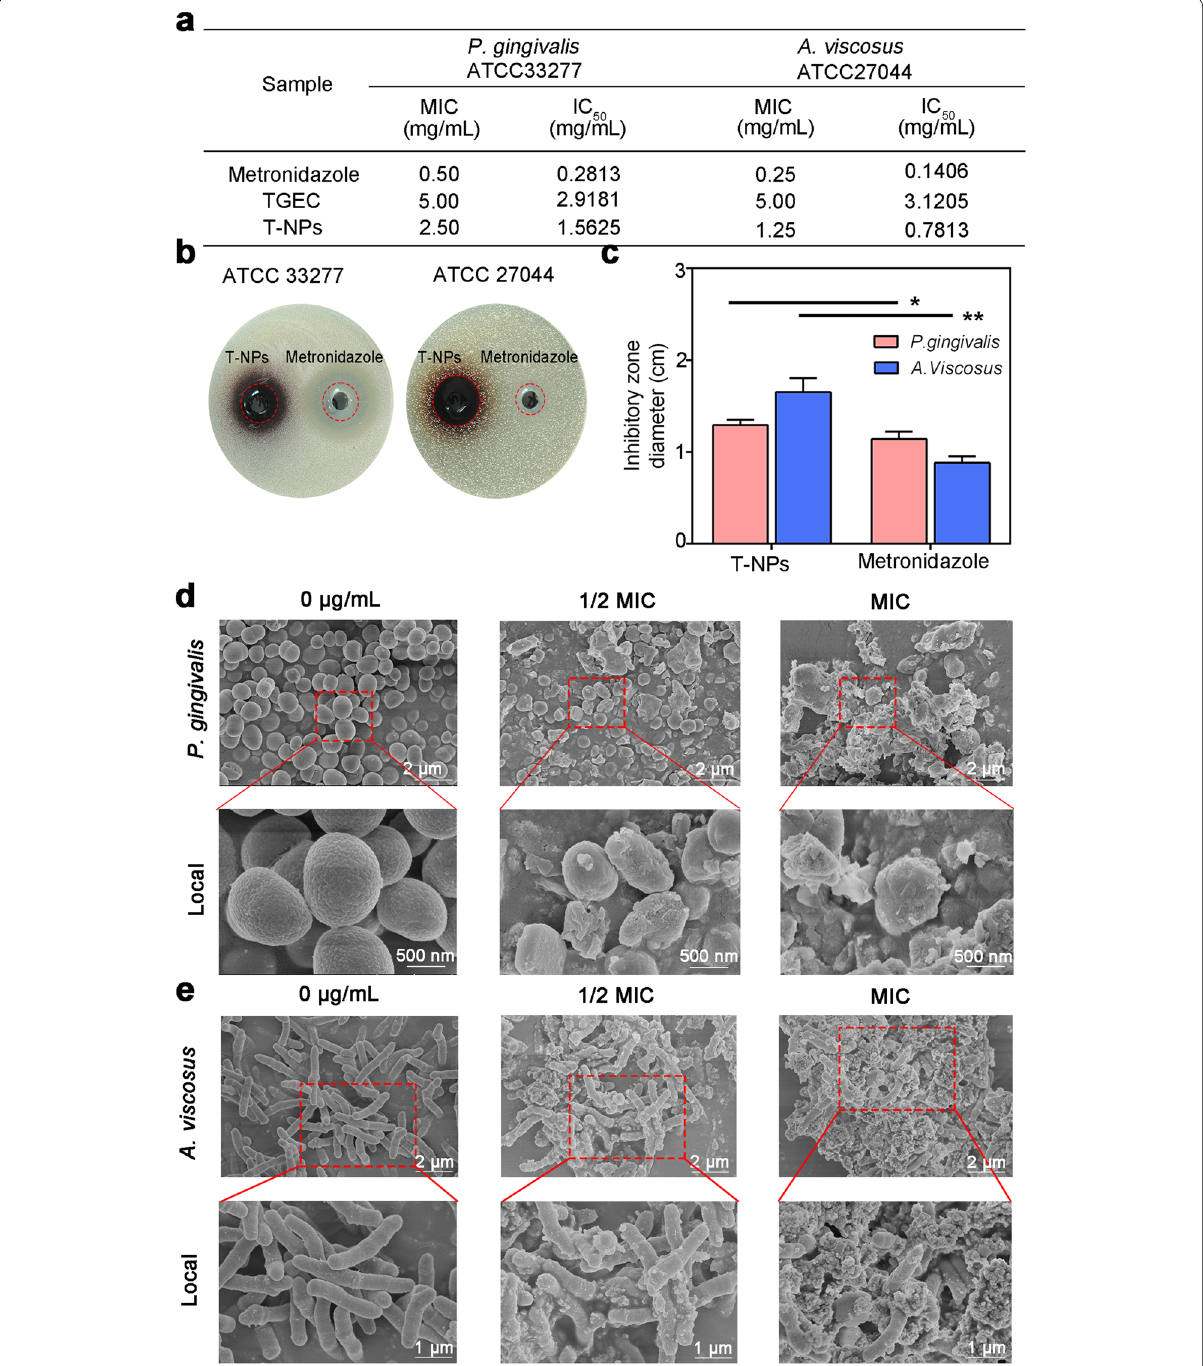
Fig. 6 Antibacterial property of T-NPs. a MIC and IC 50 of samples on P. gingivalis or A. viscosus . b Inhibition zone image of T-NPs on P. gingivalis or A. viscosus . c Quantification of inhibition zone. d P. gingivalis and e A. viscosus cultured in the medium with 1/2 MIC of T-NPs, MIC of T-NPs or without T-NPs. d SEM images of P. gingivalis and e A. viscosus cultured in the medium with 1/2 MIC of T-NPs, MIC of T-NPs or without